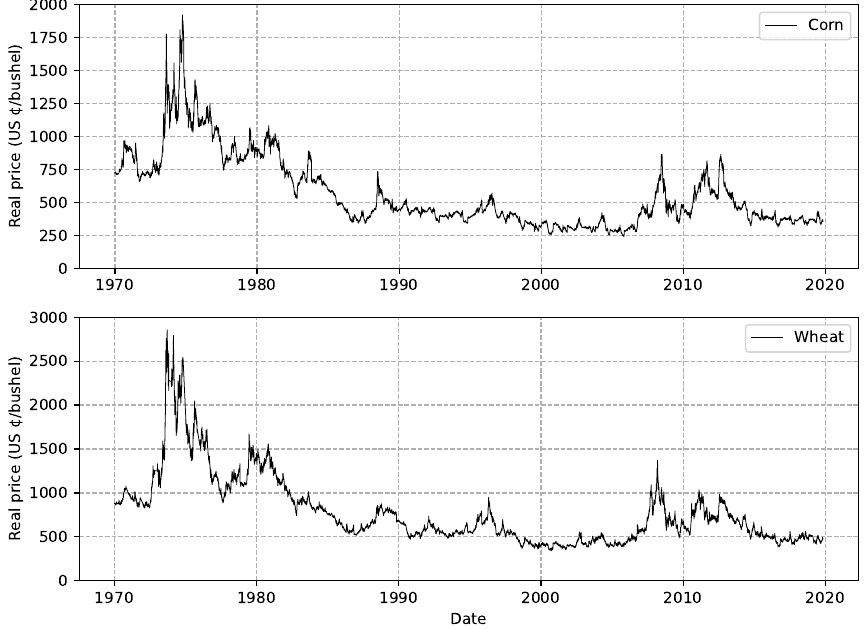
Figure 4. Daily real prices (US ¢/bushel) for corn ( top panel ) and wheat ( bottom panel ), 1970–2019.